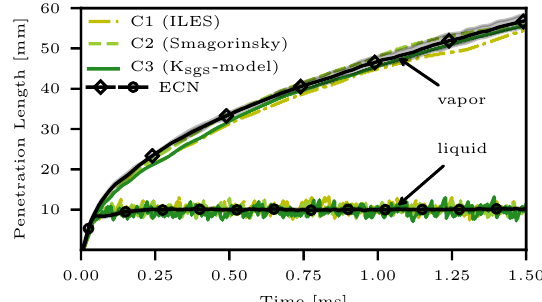
Figure 11. Time-resolved liquid and vapor penetration for varied SGS models, using the no-breakup model and constant D cyl = 5 d n , compared to ECN data. Filled region denotes ECN experimental uncertainty within an ensemble-average.